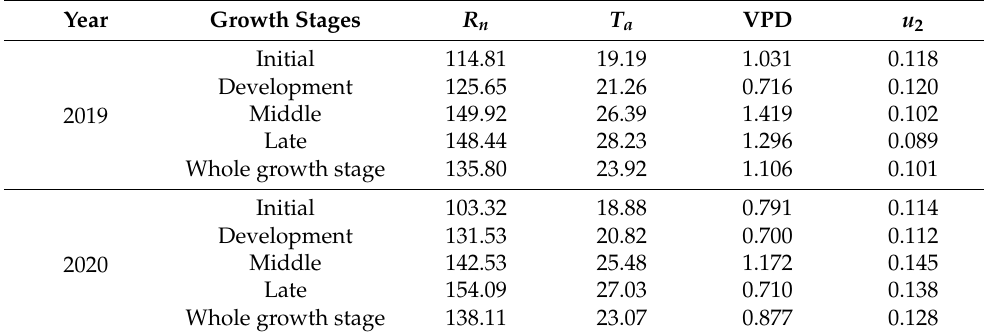
Table 2. Average of net radiation ( R n , W m − 2 ), air temperature ( T a , ◦ C), wind speed ( u 2 , m · s − 1 ) and water vapor deficit (VPD, kPa) at four growth stages in 2019 and 2020. Year Growth Stages R n T a VPD u 2 Initial 114.81 19.19 1.031 0.118 Development 125.65 Middle 149.92 2019